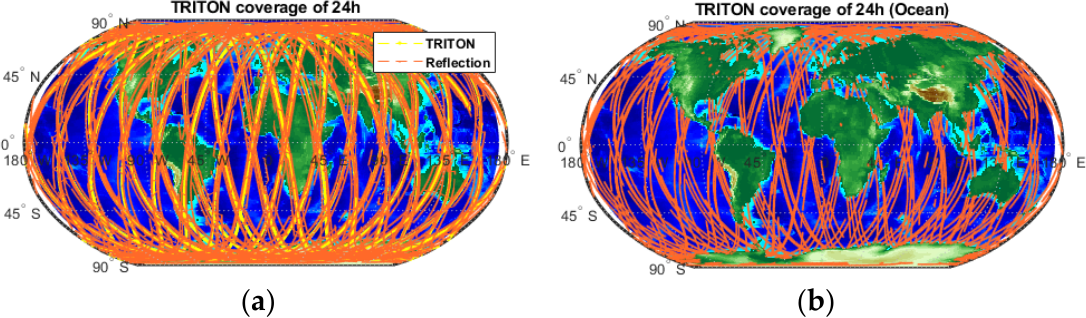
Figure 1. ( a ) Simulated TRITON ground tracks and reflection event coverage concerning GPS satellites for a 24-hour period. ( b ) Shown is the reflection point over the ocean only. The broken yellow line indicates the ground tracks of the TRITON satellite, and the broken orange line indicates the reflection points from four GPS satellites with the highest elevation angle.